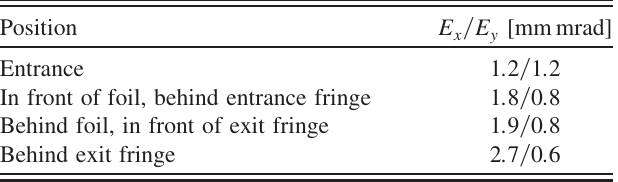
CONCEPT FOR CONTROLLED TRANSVERSE EMITTANCE . . TABLE I. Eigenemittances along the proposed rms emittance transfer section along the UNILAC. Position E x =E y [mm mrad] Entrance 1 : 2 = 1 : 2 In front of foil, behind entrance fringe Behind foil, in front of exit fringe Behind exit fringe